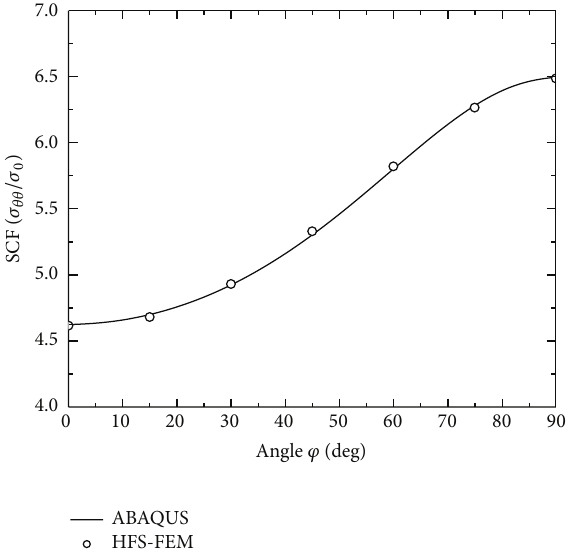
Figure 20: Variation of SCF with the lamina angle 𝜑 .